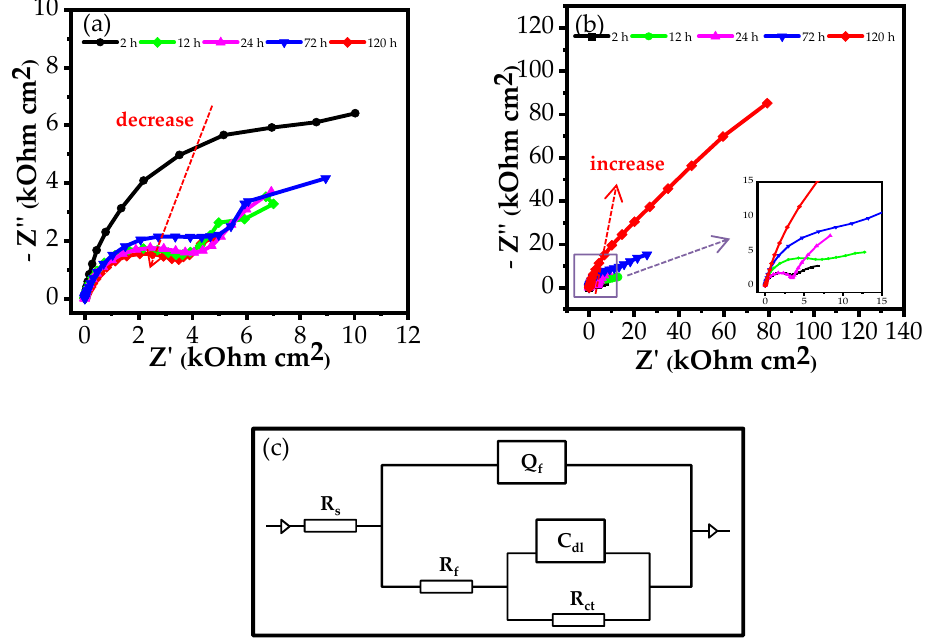
Figure 5. Nyquist plots of AA2024-T3 in ( a ) 3.5% NaCl solution, ( b ) 3.5% NaCl solution in the presence of (TEPA/CSS) 2 Ce with immersion time, and ( c ) the corresponding equivalent circuit for EIS curves of the Al alloy in 3.5% NaCl and 3.5% NaCl-containing (TEPA/CSS) 2 Ce.